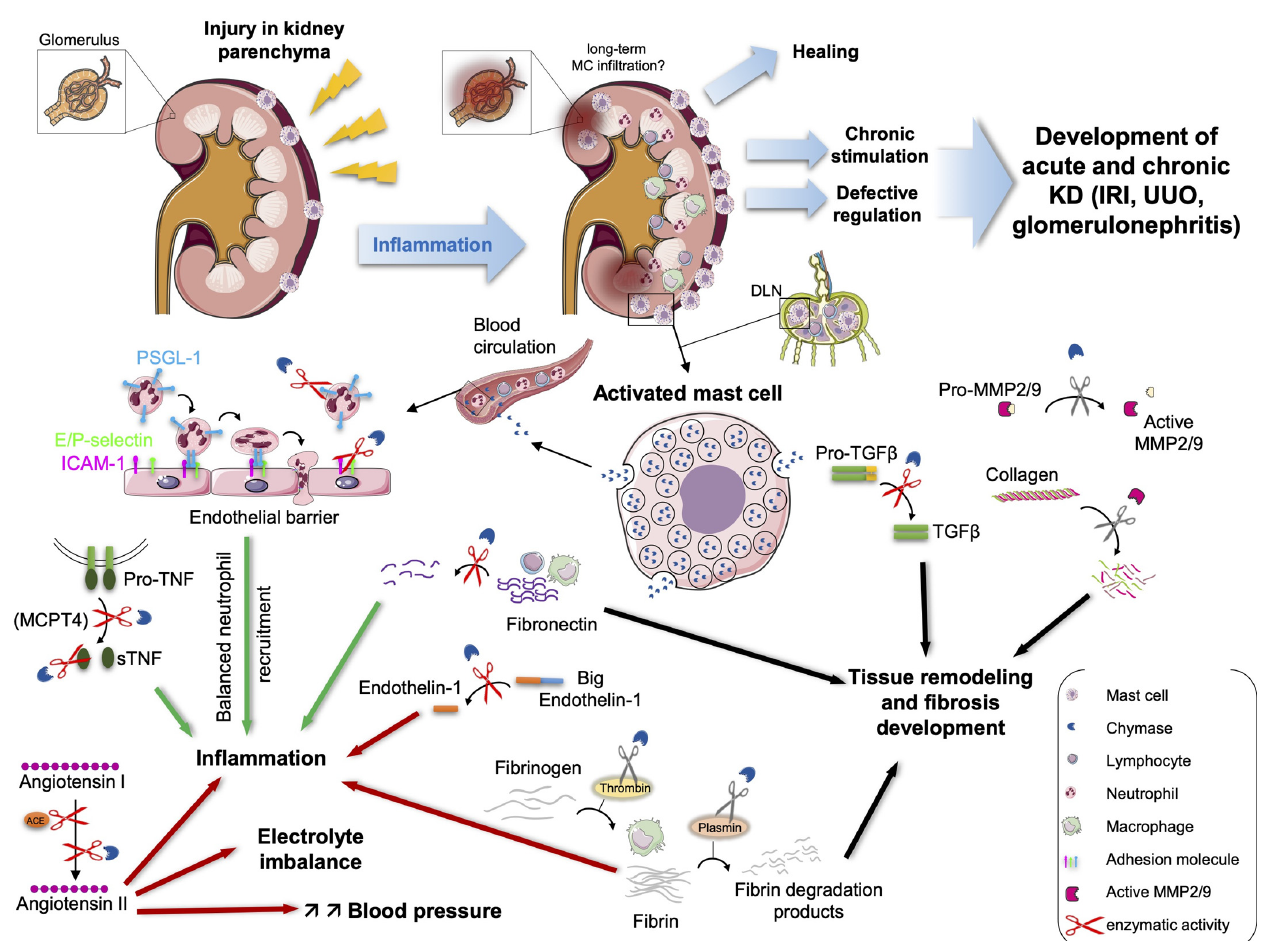
Figure 1. Proposed functions of chymase in kidney disease according to the explications provided in the text. The red scissors indicate enzymatic activity in KD, as demonstrated in scientific publications, while the grey scissors indicate possible activities in KD. The green arrows indicate positive protective functions of chymase. The red arrows indicate disease-aggravating functions of chymase.